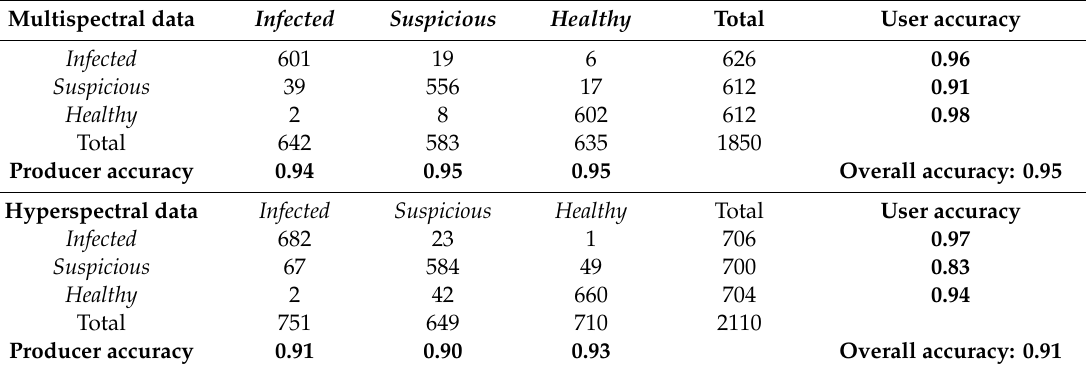
Table 2. Confusion matrices and accuracies for the multispectral (top) and hyperspectral (bottom) Random Forest